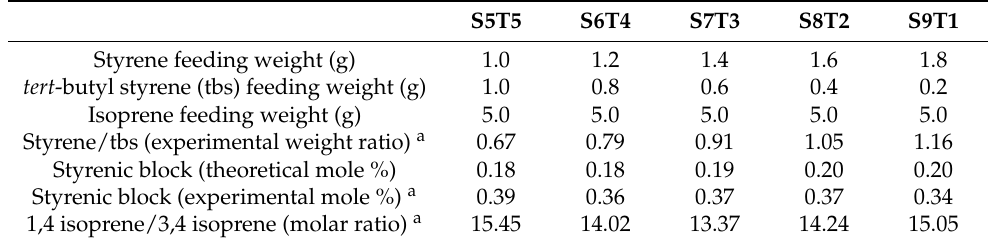
Table 1. Composition of different SIS